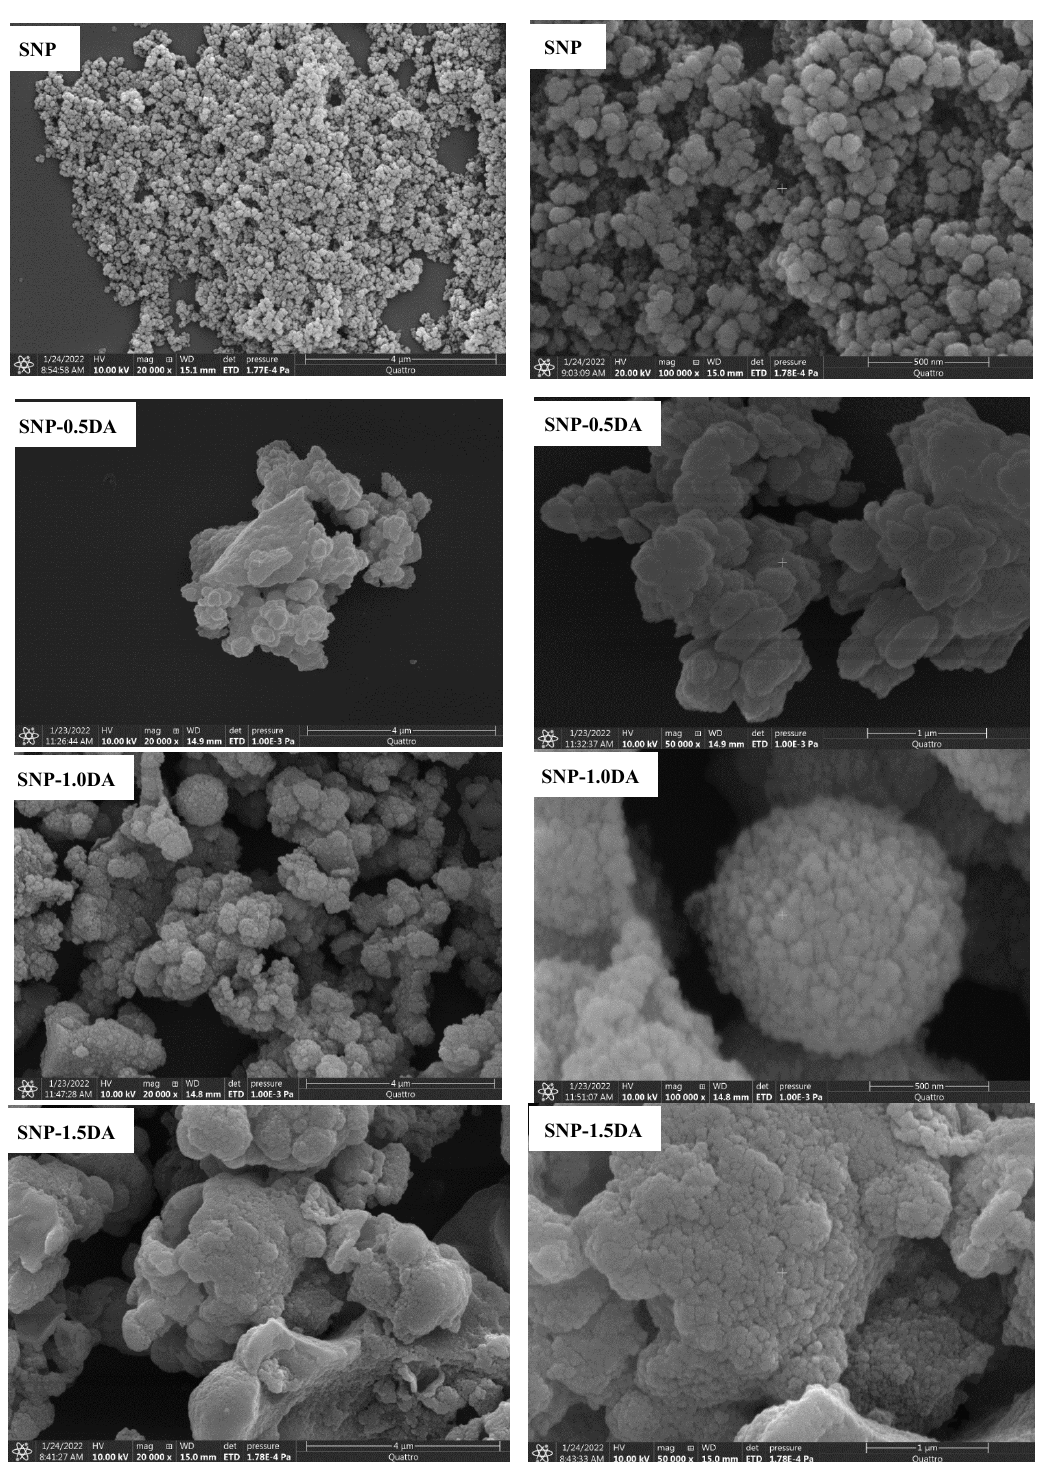
Figure 7. The SEM images of the nanocomposites were prepared with different amounts of DA at two different magnifications.